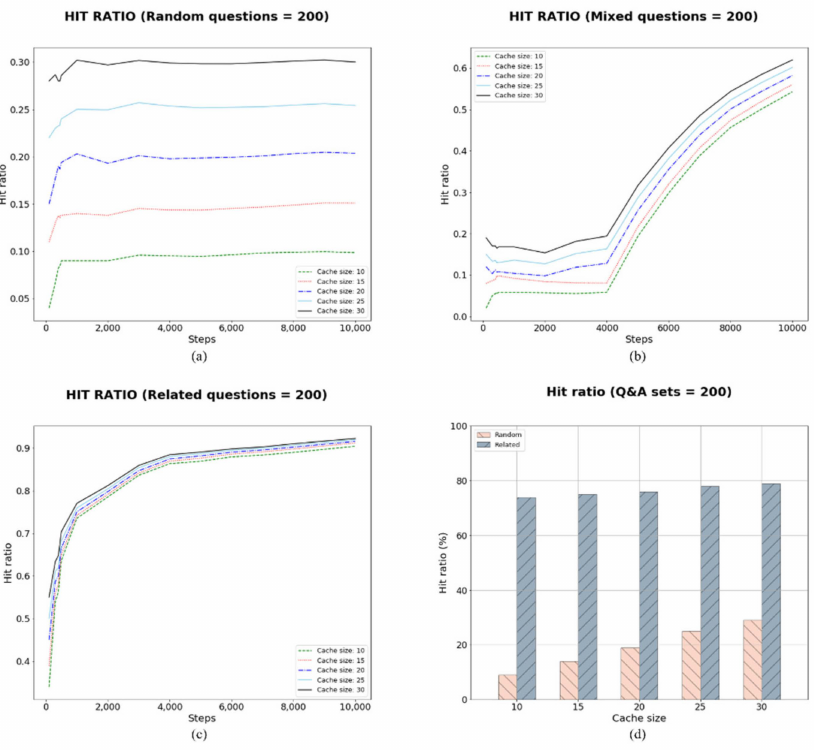
Figure 8. Experimental results of C4. ( a )—results of C2 with the random sequence; ( b )—results of C2 with the mixed questions sequence; ( c )—results of C2 with the related questions sequence; ( d )—the overall results of